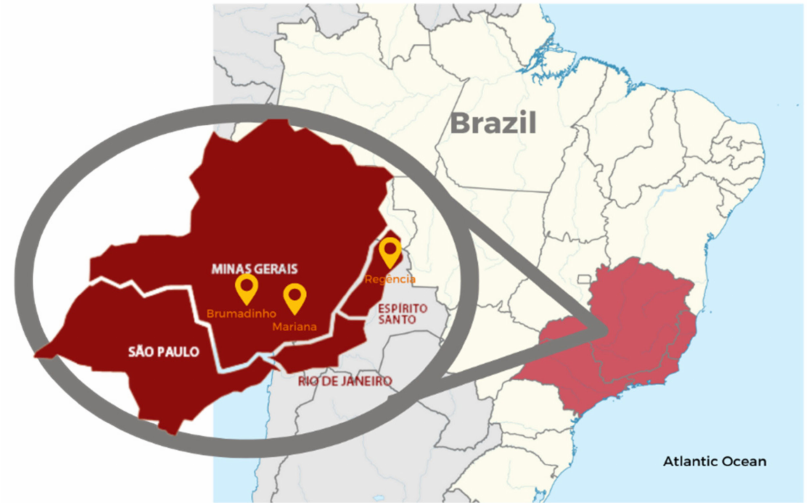
Figure 1. Map of Mariana and Brumadinho in Minas Gerais and Reg ê ncia in Esp í rito Santo. (Source: adapted from the Brazilian Institute of Geography and Statistics